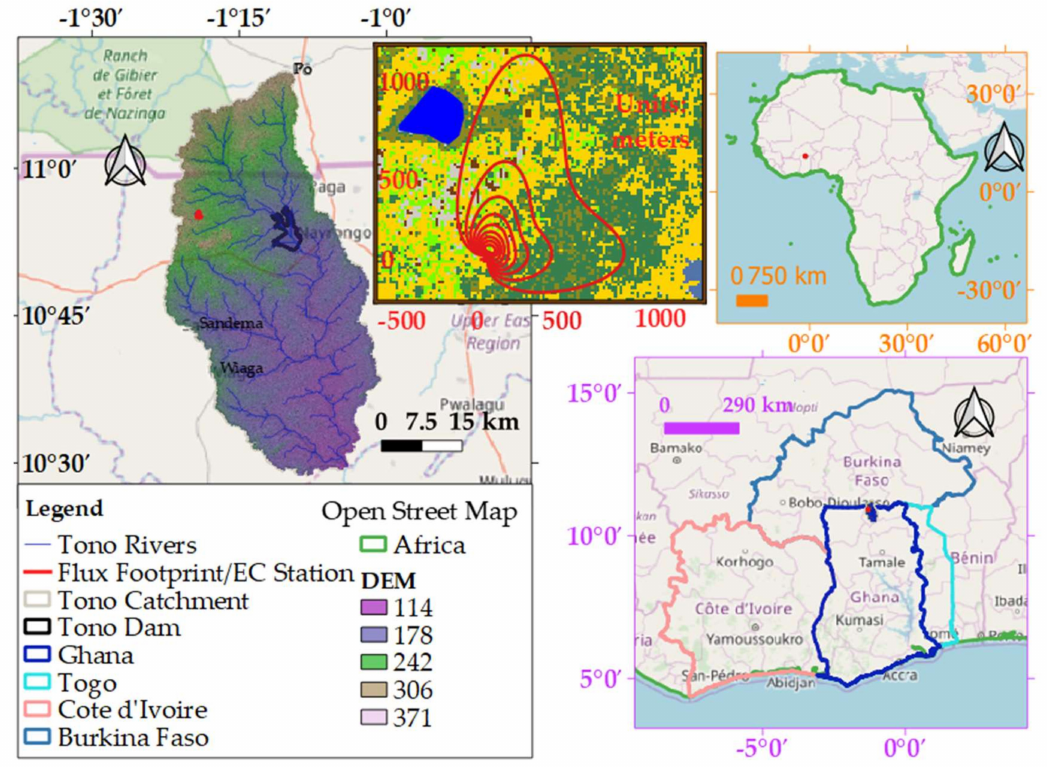
Figure 1. Map of Africa showing neighboring countries and contour lines of flux footprint from the Kayoro eddy covariance (EC) station within the study location of the Tono Catchment in Ghana and Burkina